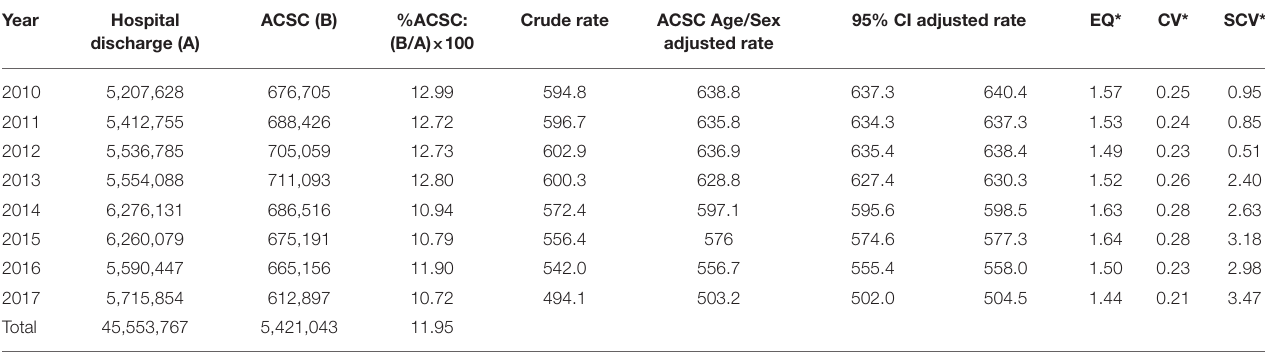
TABLE 2 | Global hospital discharge in Mexico: Variation 2010–2017.